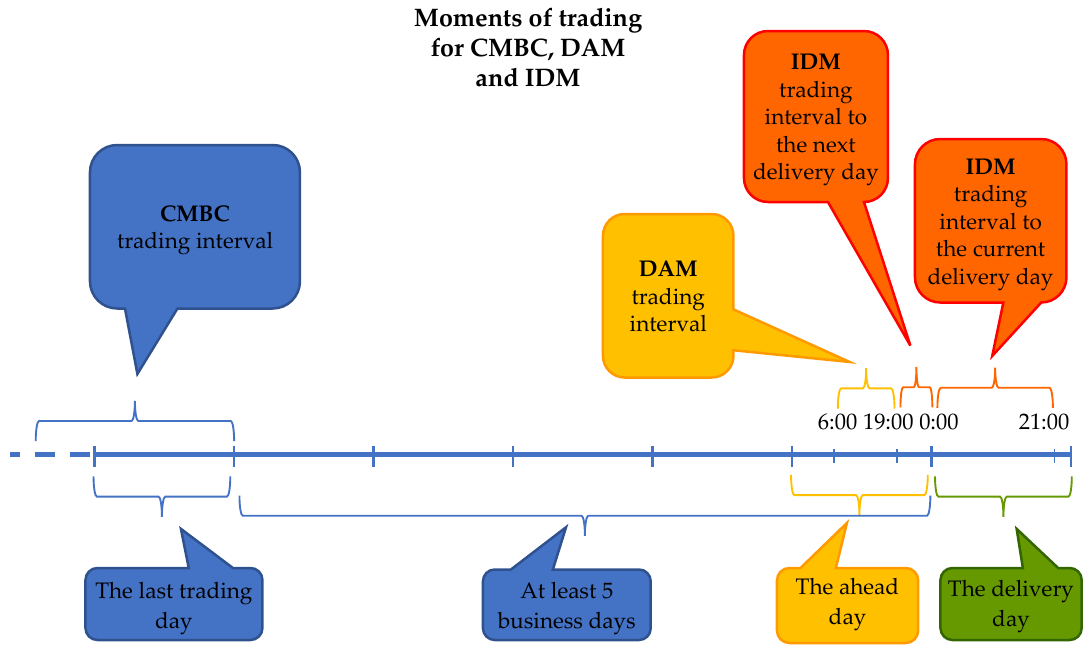
Figure 1. Trading electricity on Centralized Market for Electricity Bilateral Contracts (CMBC), Day-Ahead Market (DAM), and Intra-Day Market (IDM).